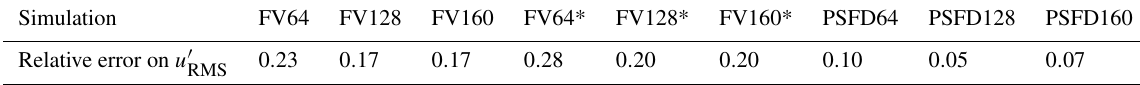
− u (cid:48) || || / || u (cid:48) L 2 L 2 w.r.t. the reference profile from Hultmark et al. RMS RMS , ref RMS , ref